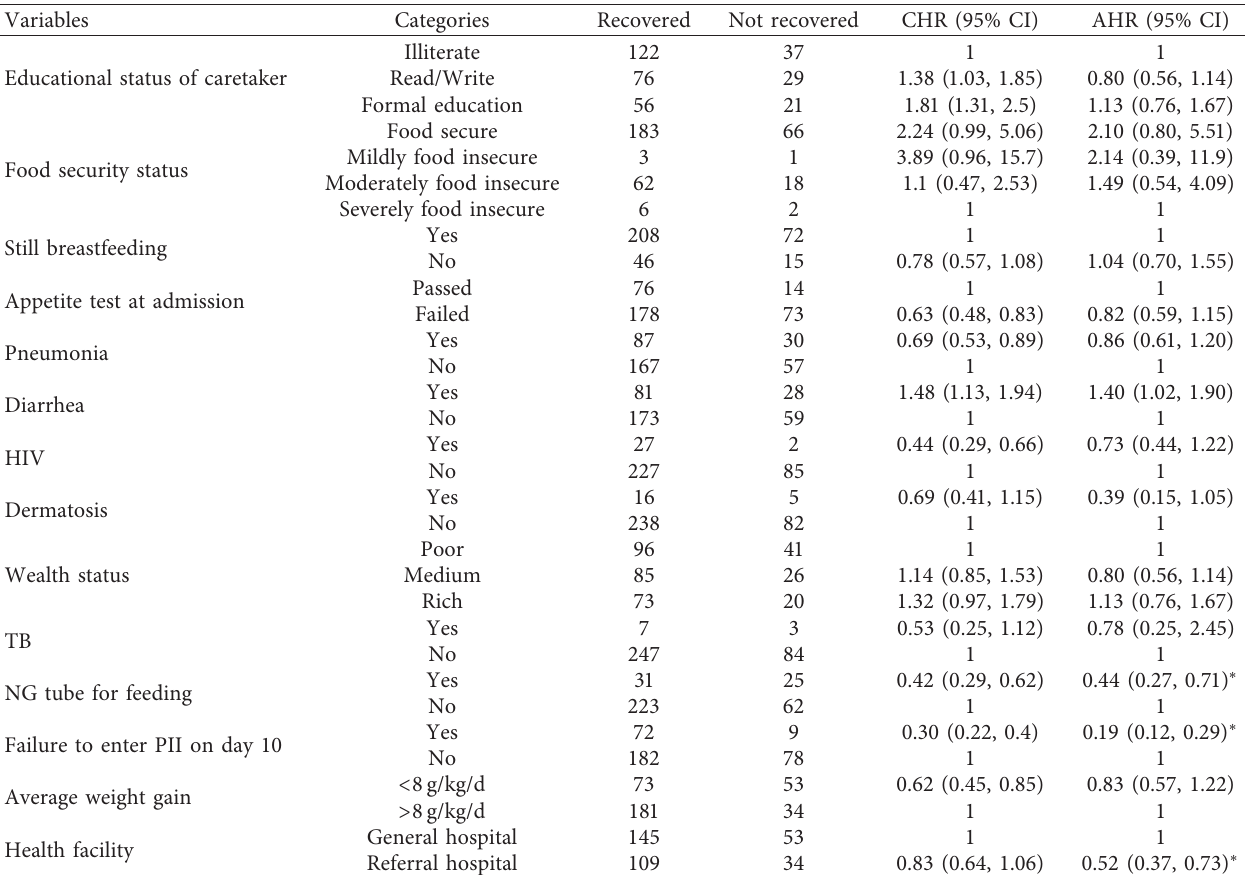
Table 3: Predictors of nutritional recovery time among children 6–59 months with SAM managed to East Amhara Public Hospitals, North East Ethiopia,